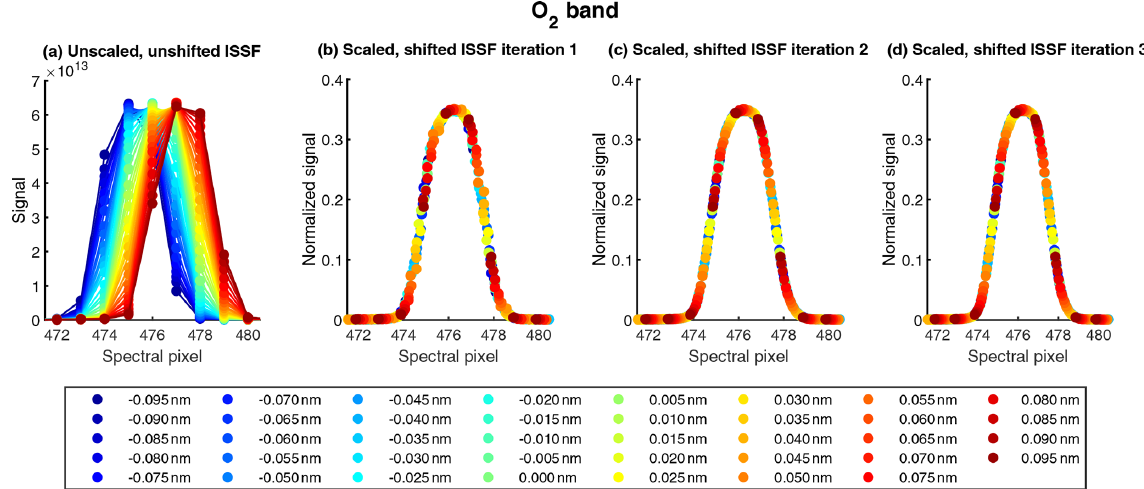
Figure 10. Demonstration of ISSF oversampling for the O 2 band at a central wavelength of 1275nm and spatial pixel 500. ISSF processing is as described in Fig.